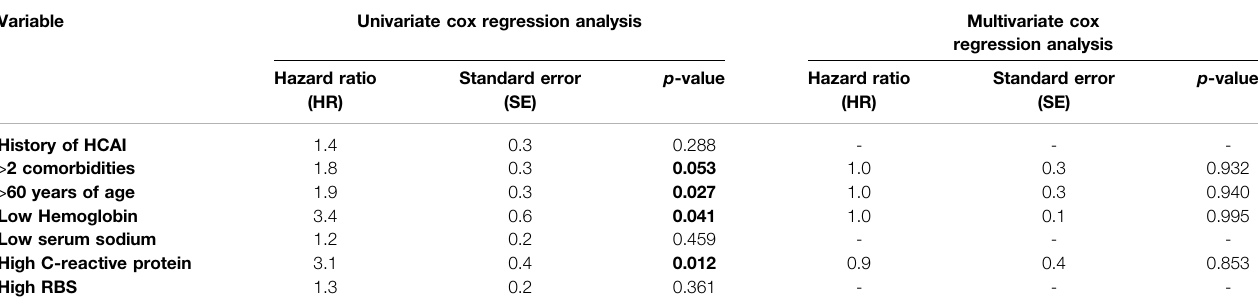
TABLE 3 | Univariate and multivariate Cox regression analysis of study participants ’ predictors for survival.